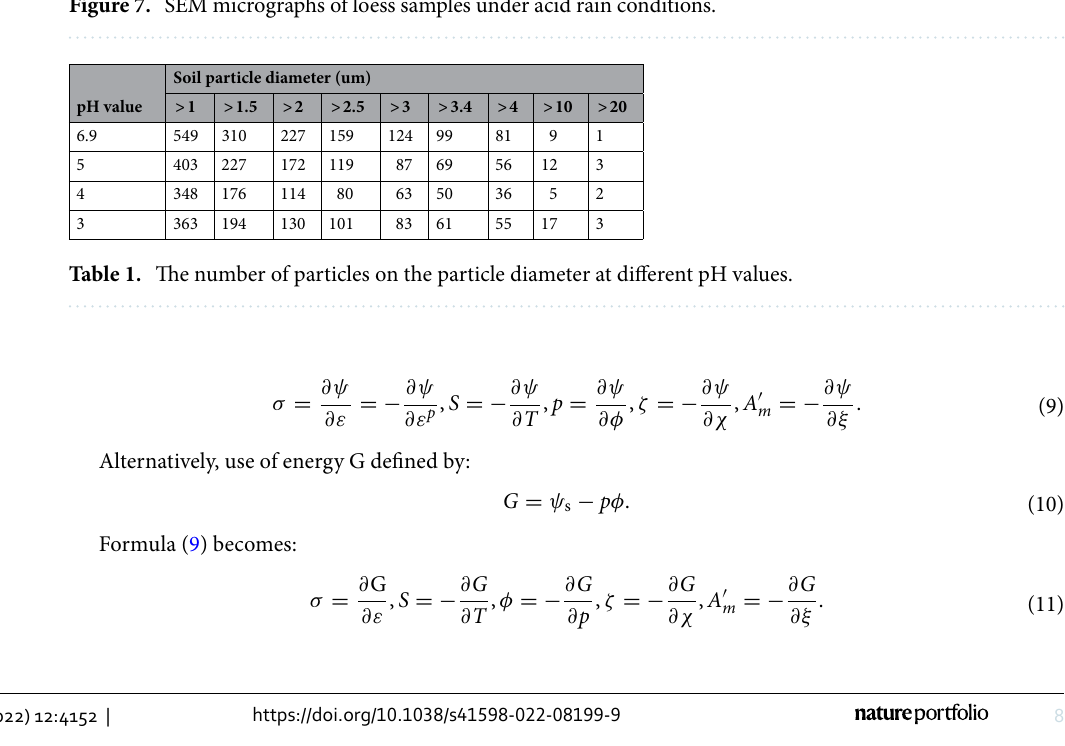
Figure 7. SEM micrographs of loess samples under acid rain conditions.